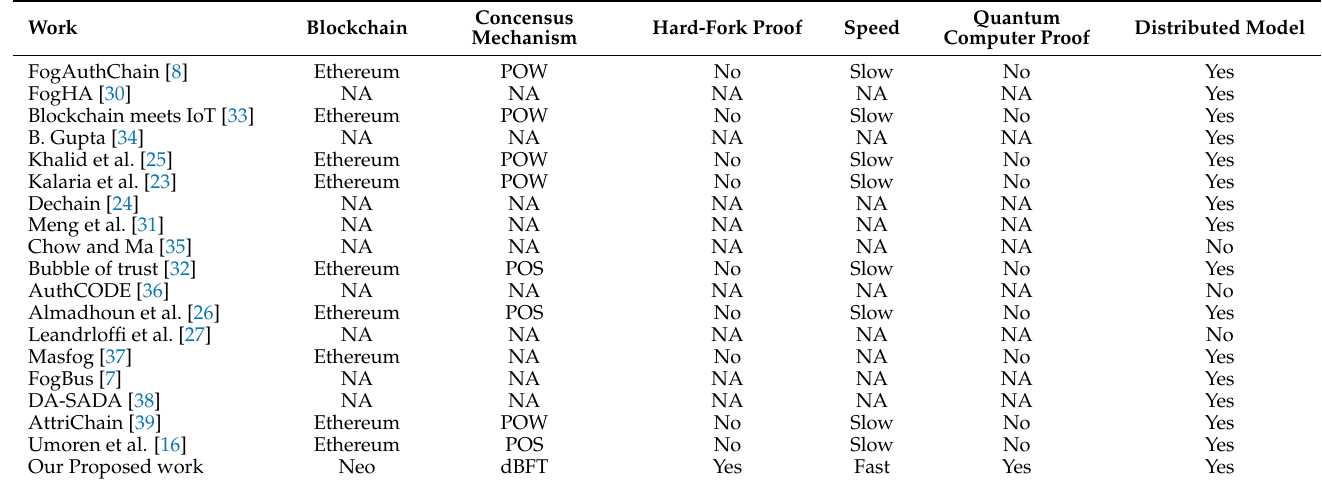
Table 1. Analysing existing work based on the type of blockchain used, consensus mechanism, hard-fork proof, speed, quantum computer proof, and distributed model. (NA = Not